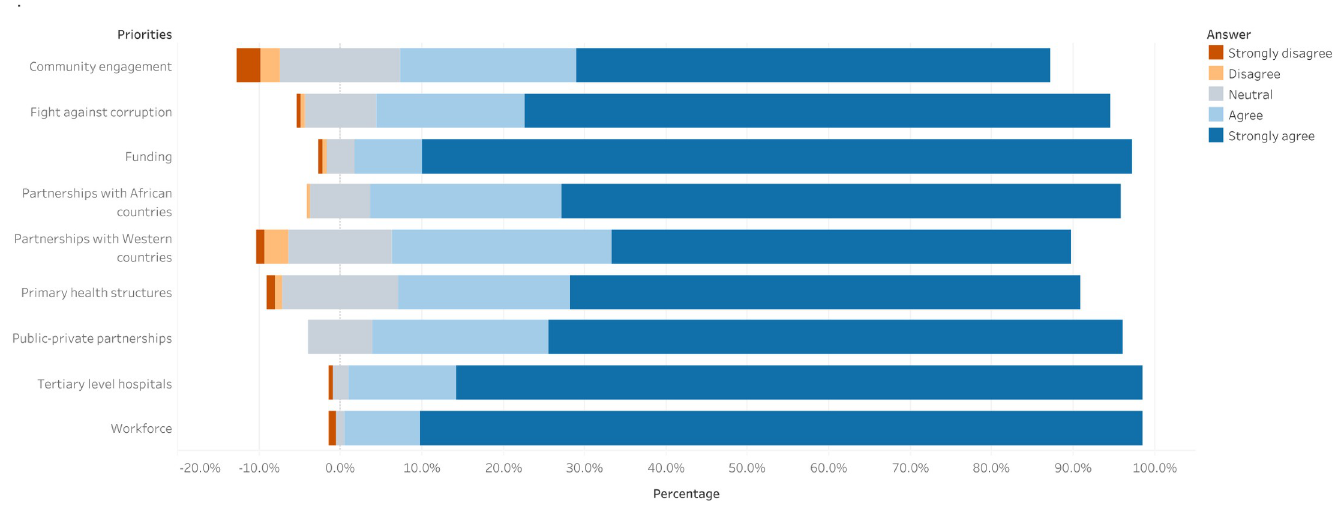
Fig 2. Global surgery priorities in Cameroon according to final year medical students.